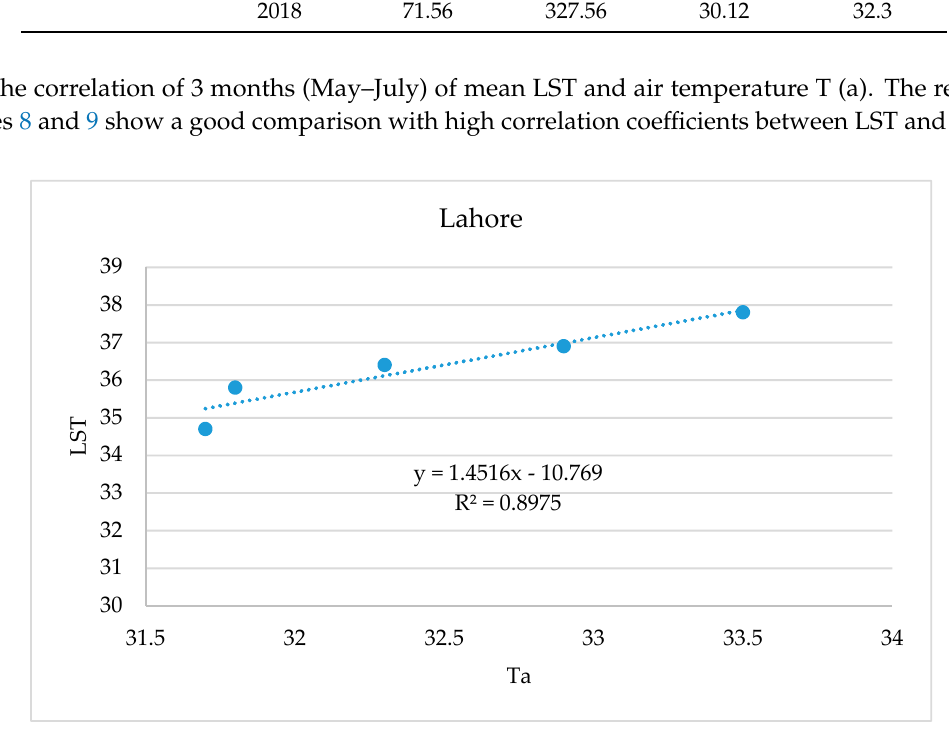
Figure 8. Scatterplot of LST versus Ta (3 months average (May–July) for Lahore city.